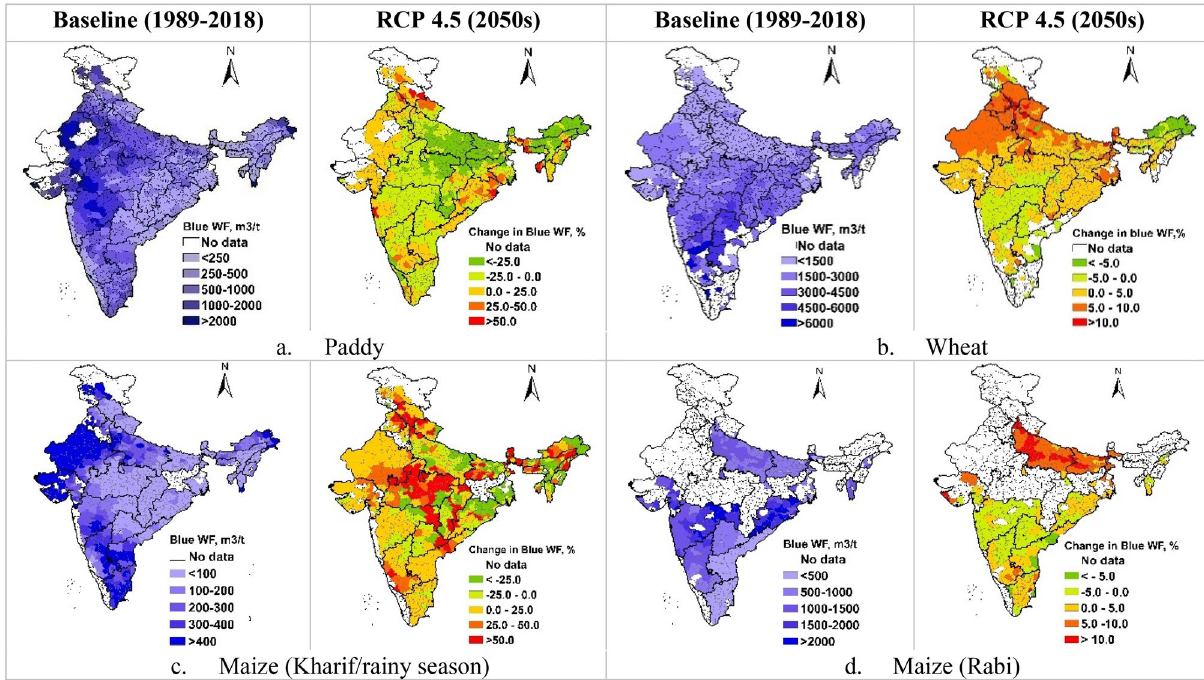
Figure 5. ( a–d ) Spatial variation in the blue WF (m 3 /t) of crop production under baseline scenario (1989– 2018) and respective percentage variations under RCP4.5 2050s. These maps were generated using ArcGIS 10.8.1 (https:// www. arcgis. com/ index. html).